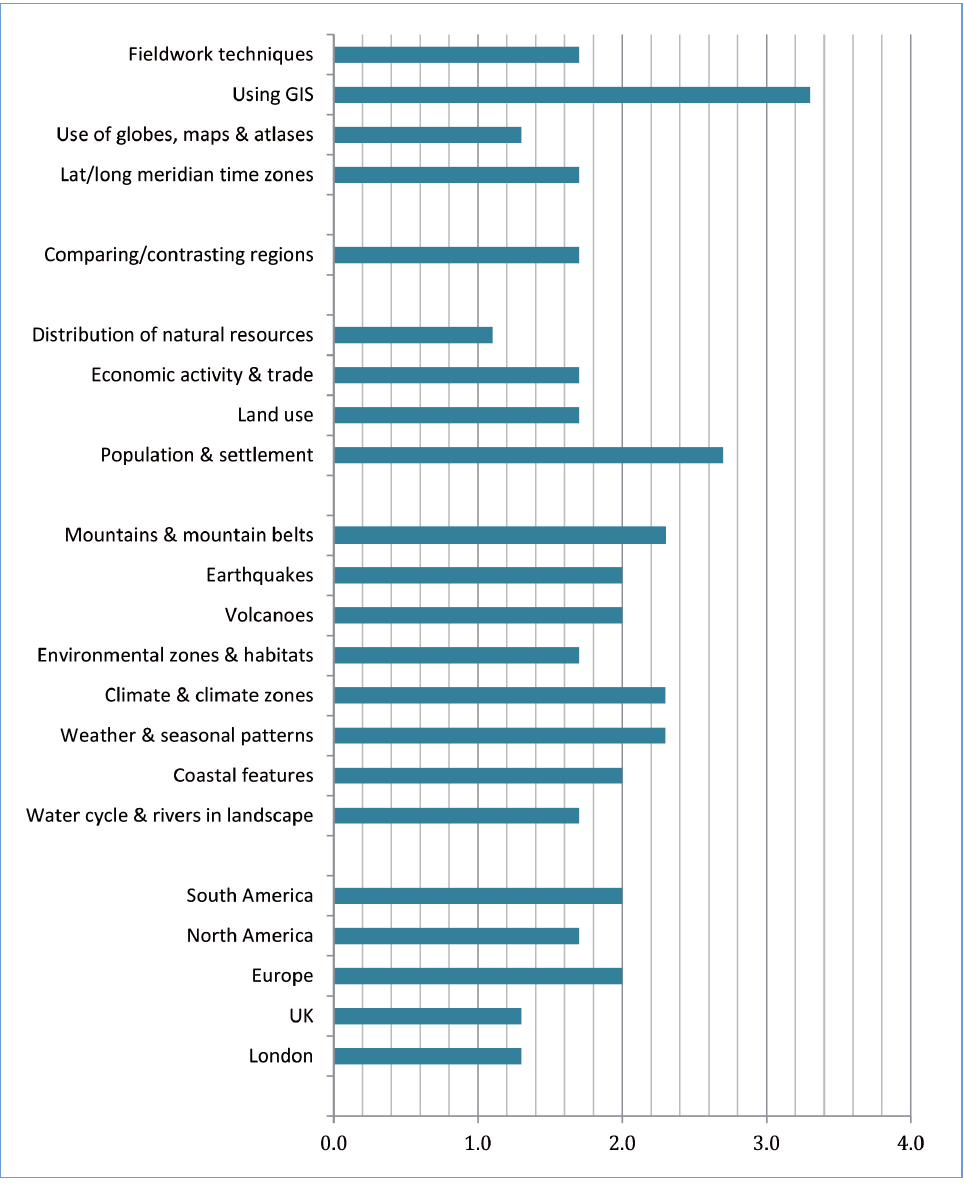
Figure 4: Overallshiftinprimaryteachers’confidenceofsubjectknowledge. Differenceinthemeanprimaryteachers’confidenceself-scorefornationalcurriculumtopics betweenthebaselinesurveyandpost-projectsurvey(1.0=onewholeconfidenceshift) Thedataindicatemarkedimprovementinteachers’confidenceintheirsubjectknowledgeacross alltopics ofthenewcurriculum.Teachers’confidenceinknowledgeofallnationalcurriculum